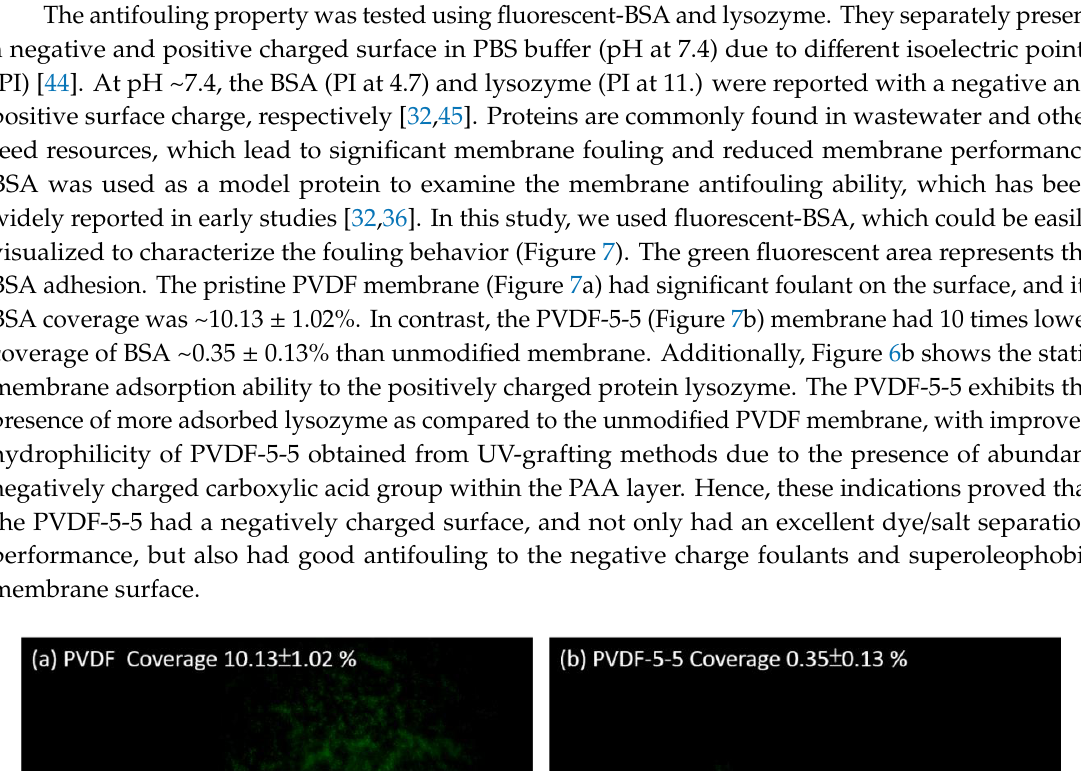
Figure 6. ( a ) Rejection properties of PVDF-5-5 membrane for 1000 mg/L of Na 2 SO 4 , MgSO 4 , MgCl 2 , NaCl solution, and 100 mg/L of Congo red (M w : 696.66) and EBT (M w : 461.38). ( b ) Static membrane adsorption ability to the positively charged model protein lysozyme.